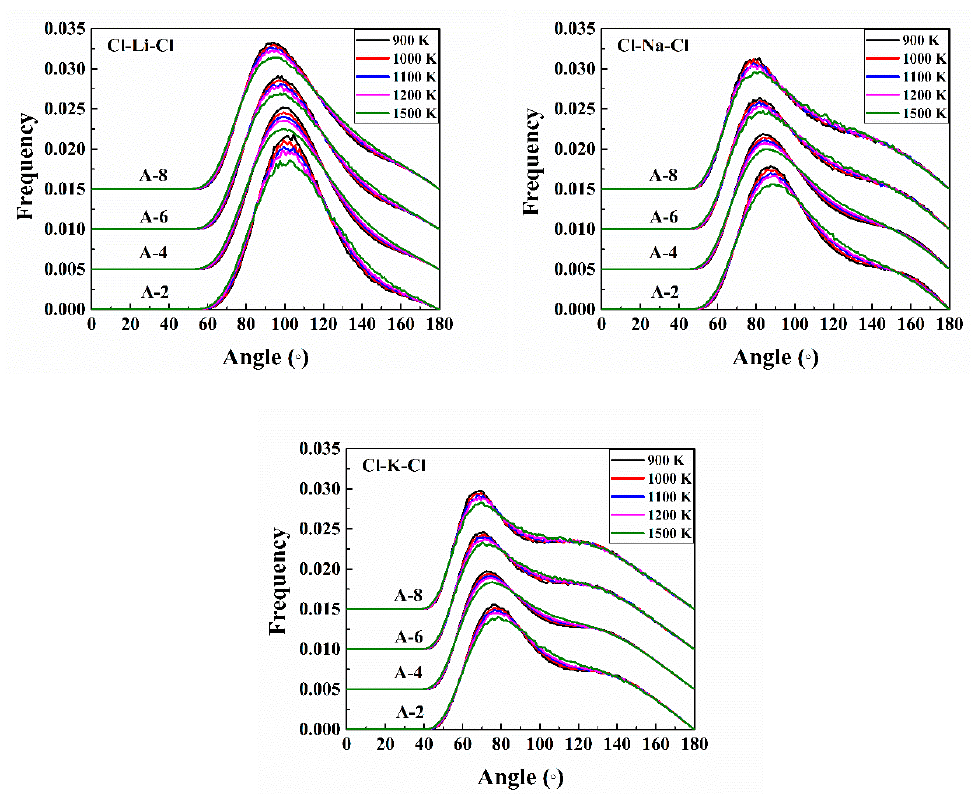
Figure A8. ADF samples of Cl-Li-Cl, Cl-Na-Cl, and Cl-K-Cl of four typical systems at different